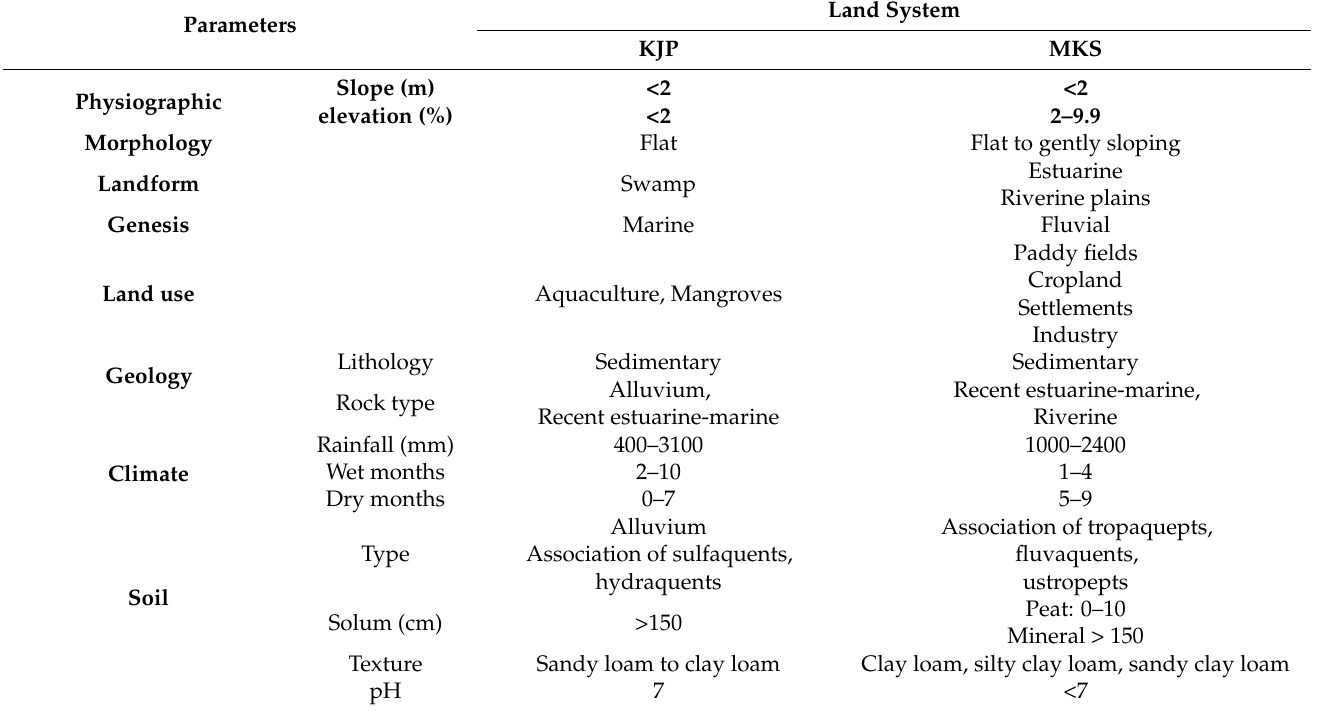
Table 3. Characteristics of the land systems of the Sayung